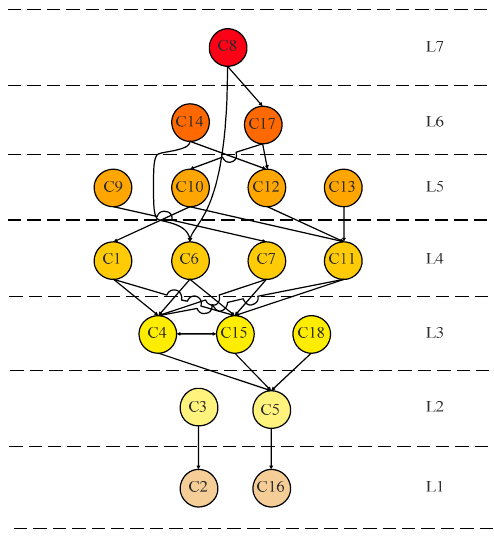
Figure 3. Multilevel hierarchical interpretative structure model of gas explosion accidents.